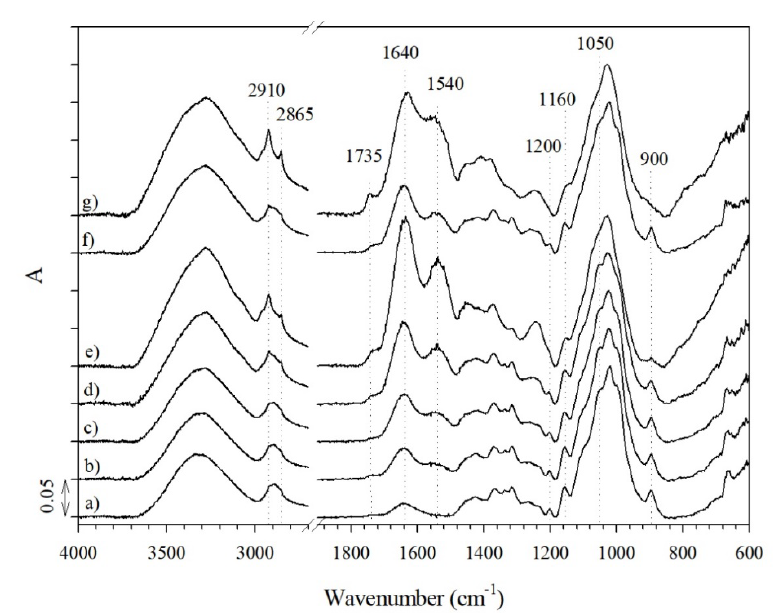
Figure 7. Attenuated total reflection (ATR) spectra of the CLY(25) sample before ( a ) and after 10 ( b ), 20 ( c ), 30 ( d ), and 50 ( e ) days of soil burial, as well as the CLY(70) ( f ) and K ( g ) samples after 50 days of soil burial.